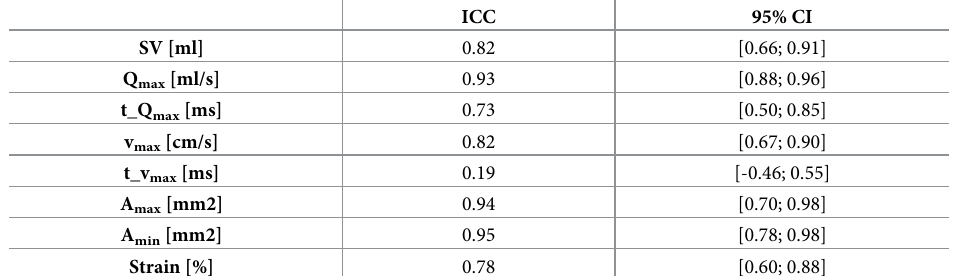
Table 4. Intraclass correlation coefficients with corresponding 95% confidence intervals for quantitative parame- ters evaluated with 2D and 4D Flow MRI in the entire study